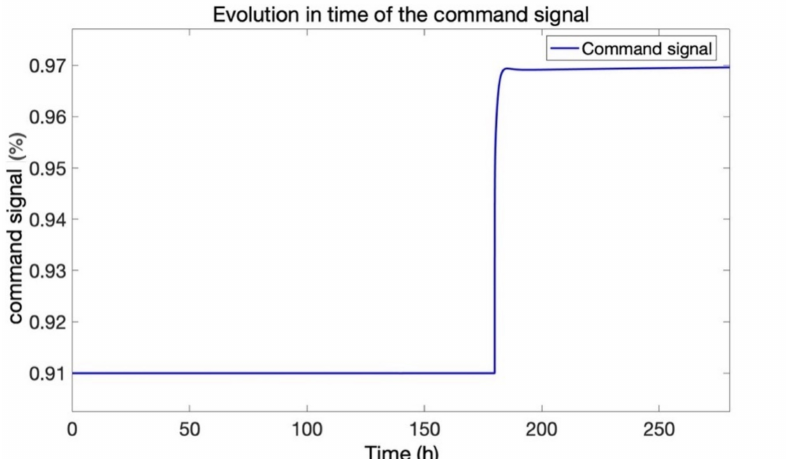
Figure 17. Evolution in time of the control signal applied in order to adapt the proposed model of the separation process when the fractional differentiation order varies from β = 0.91 to β = 0.97 at t = 180 ( h ) .